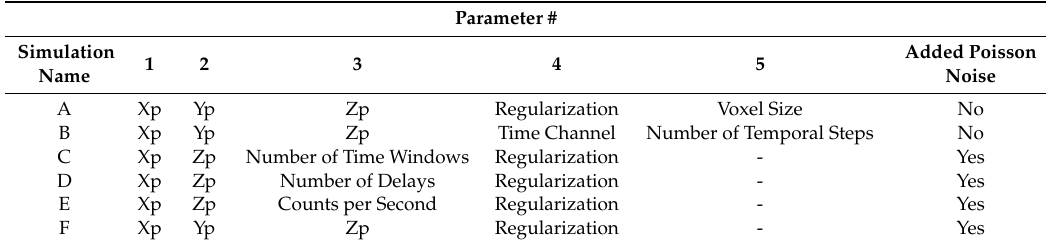
Table 1. Set of performed simulations.